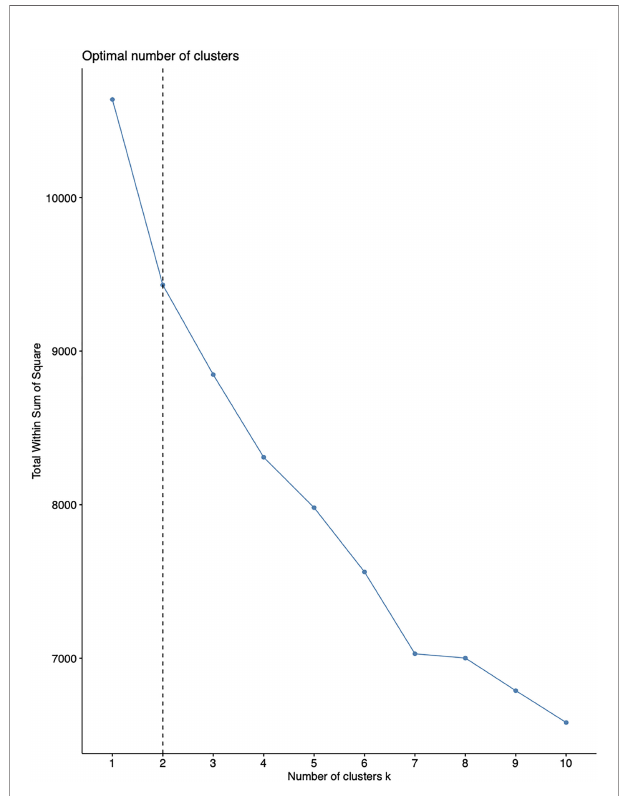
FIGURE 2 | Estimating the optimal number of clusters using gap statistics. The optimal number of clusters was estimated using gap statistics. The optimal number was indicated by the dashed